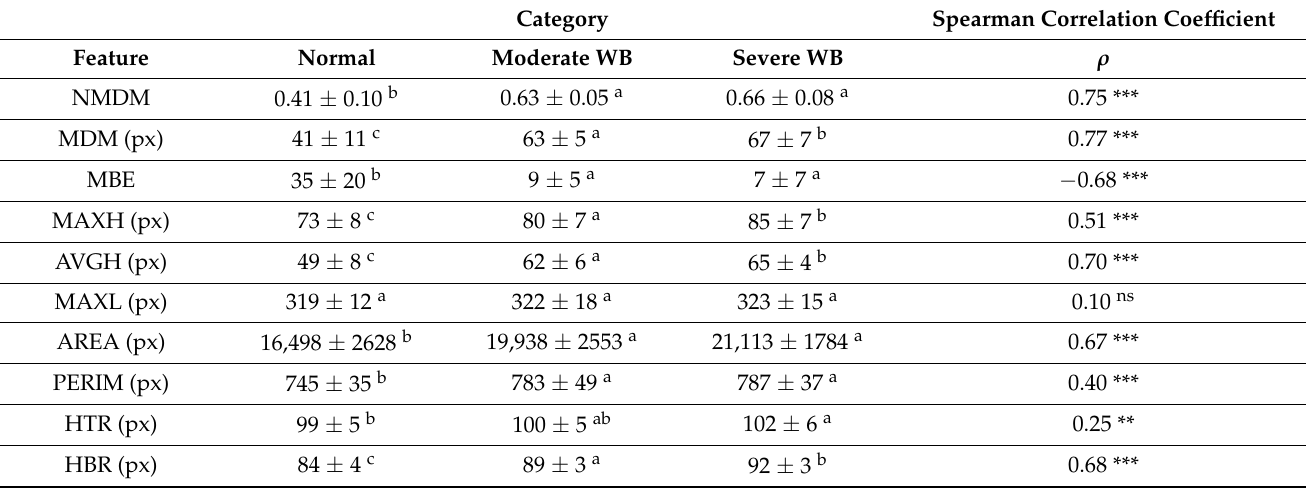
Table 2. Measurements of sideview image features of fresh broiler breast fillets.